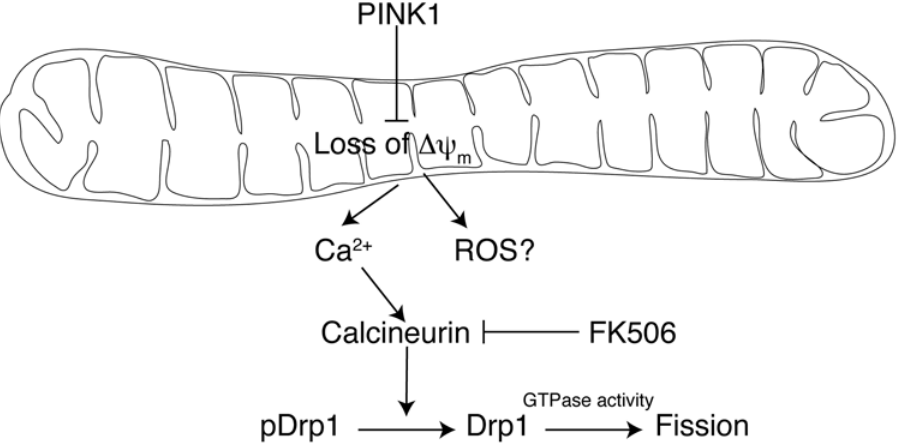
Figure 9. Proposed mechanism of altered mitochondrial morphology induced by loss of PINK1.